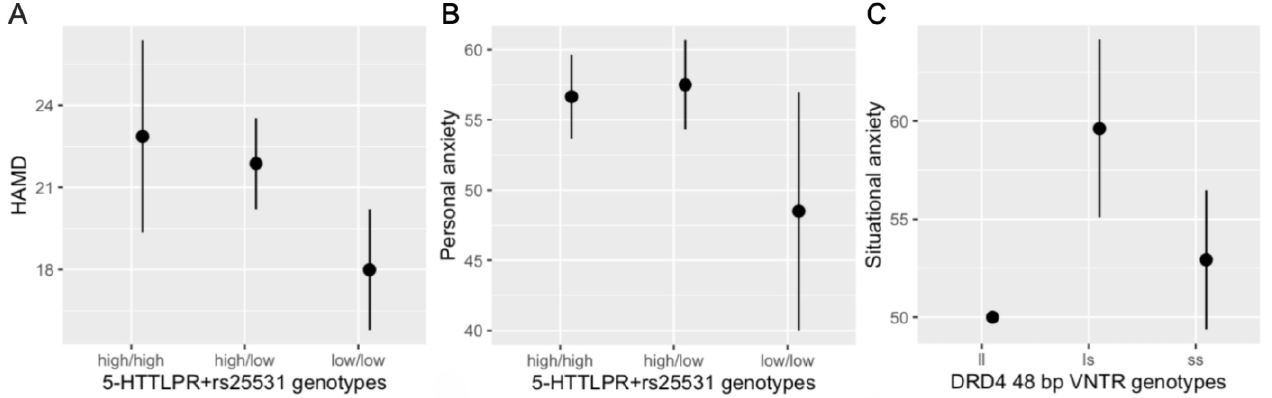
Figure 1. Levels of depression and anxiety in patients with suicidal behavior associated with studied loci. ( A ) Levels of depression according to HAMD and ( B ) levels of personal anxiety in patients with different genotypes of SLC6A4 5-HTTLPR+rs25531 locus; ( C ) levels of situational anxiety in patients with different genotypes of DRD4 48 bp VNTR locus. Table 3. Association between genes of dopamine and serotonin systems and severity of depressive, situational anxiety, and personal anxiety symptoms.